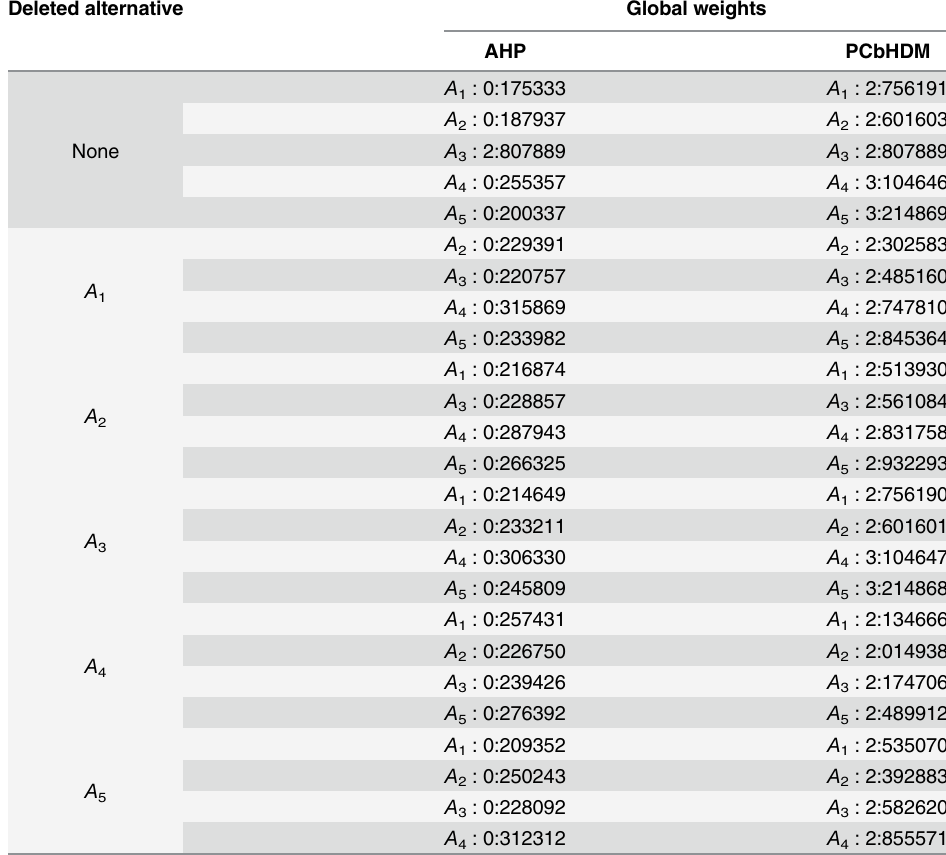
Table 7. Global weights with a single alternative deleted (consistent